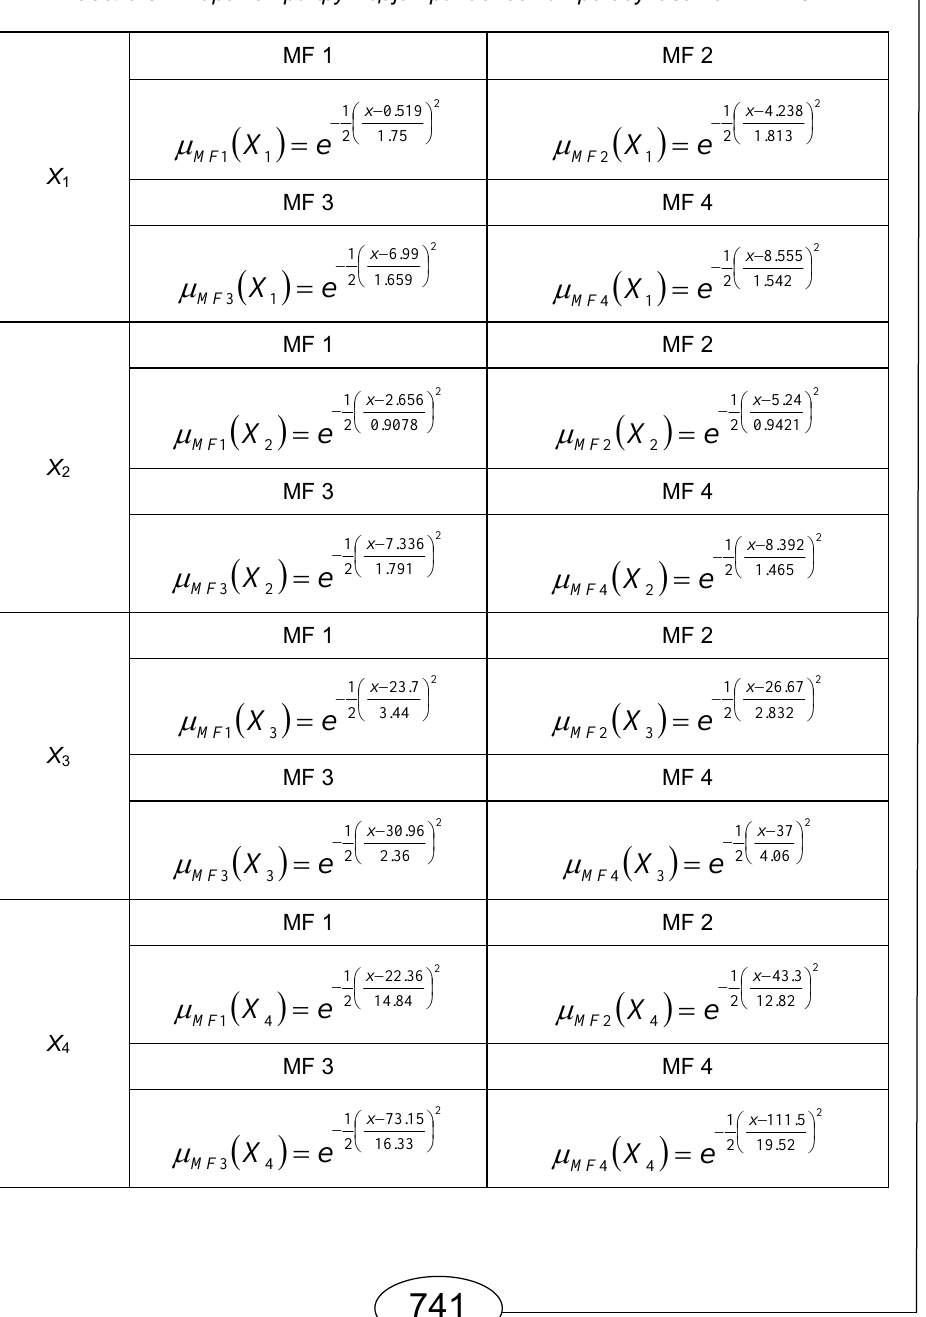
Table 3 – Parameters of the membership functions before the ANFIS